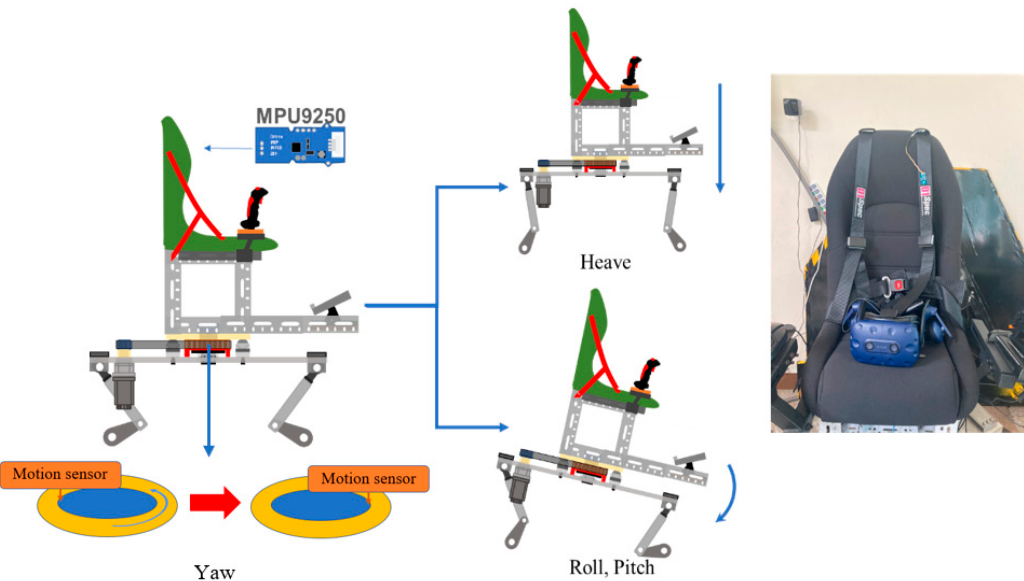
Figure 27. Heave, roll, and pitch limit G force test method.